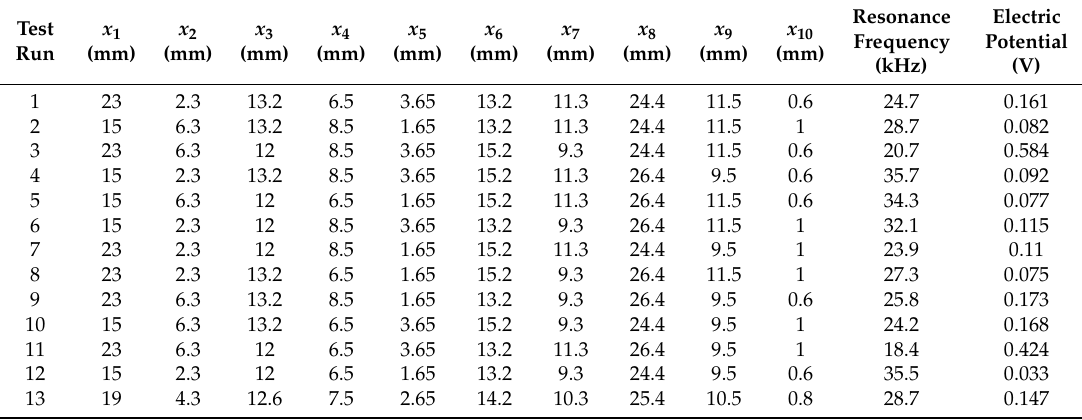
Table 3. Resonance frequency and electric potential for 13 selected test